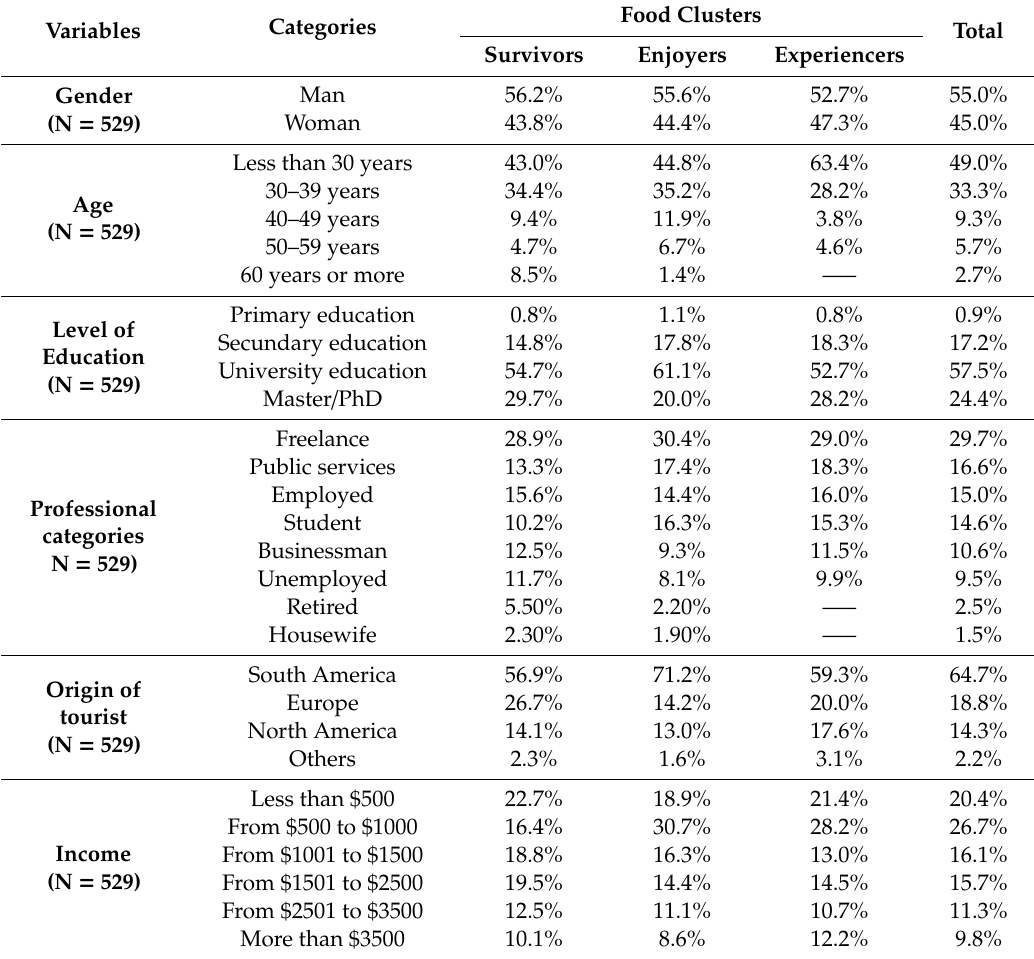
Table 3. Sociodemographic profile of foreingn tourists in